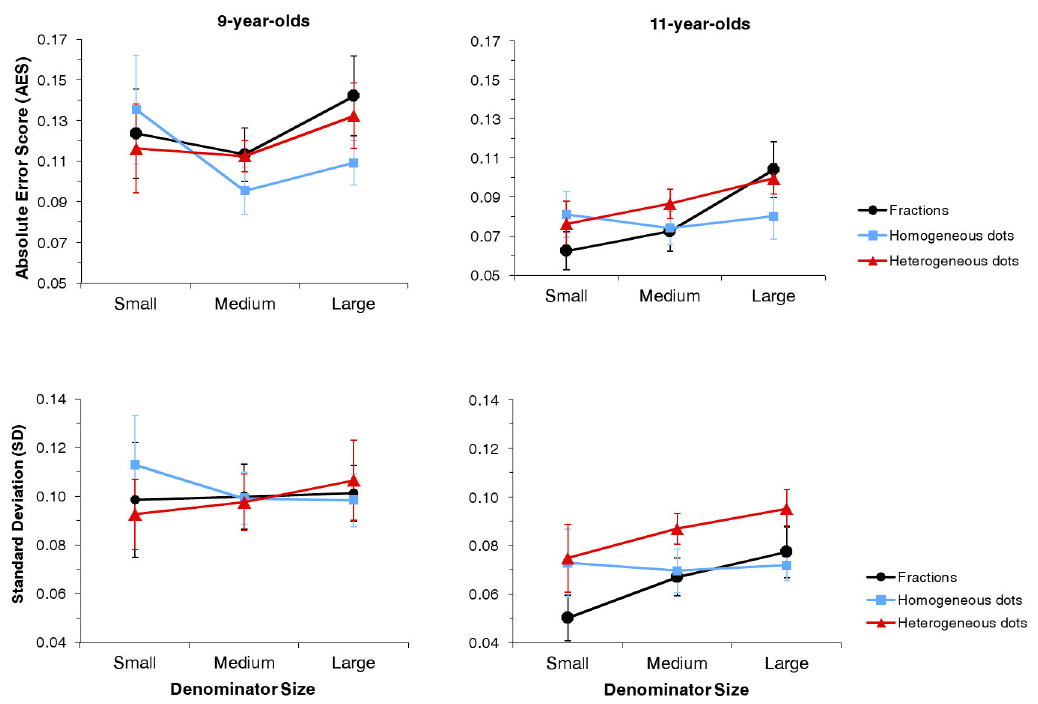
Figure 2. The mean absolute error score (top panel) and the mean standard deviation (bottom panel) according to the denominator size and the ratio format by age group. Error bars represent the 95% confidence intervals corrected according to the method suggested by Cousineau [44] for repeated measures. doi: